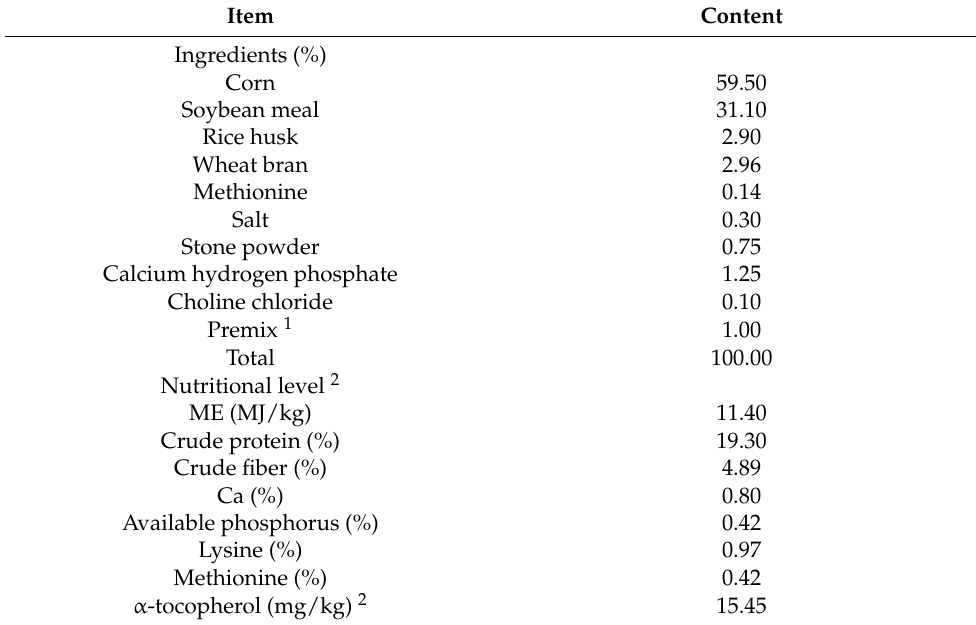
Table 1. Composition and nutrient level of the basic gosling diet (dry